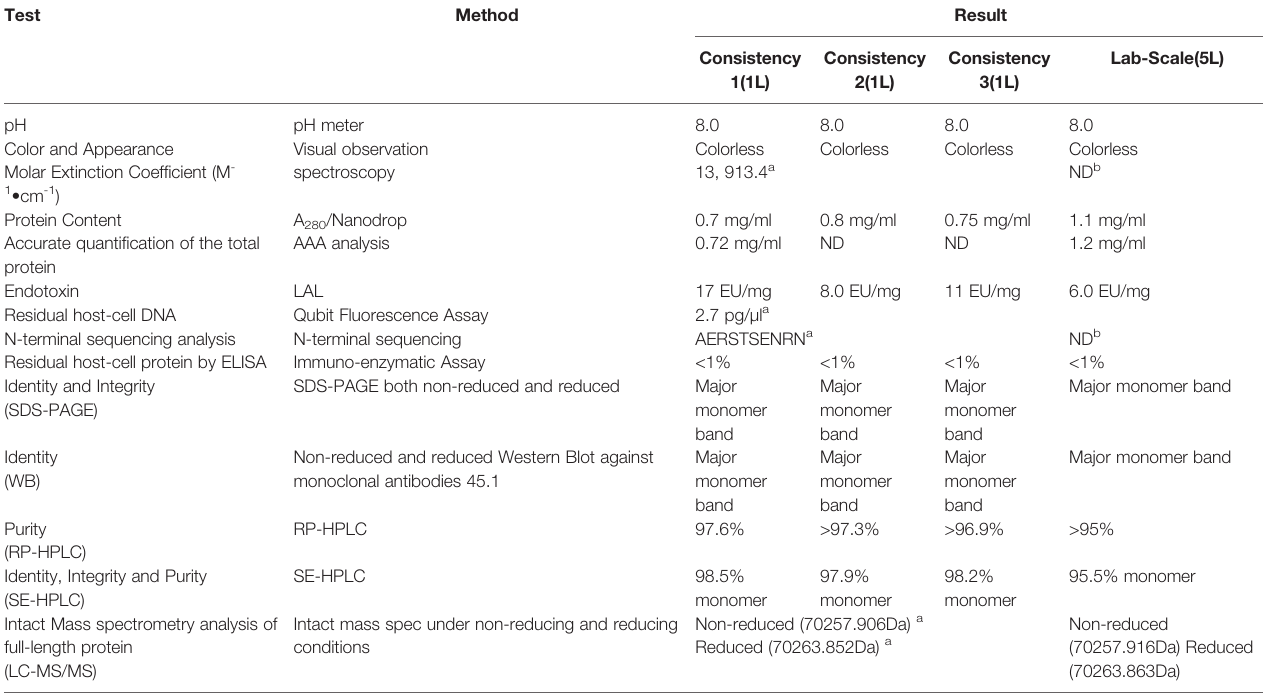
TABLE 3 | Characterization of R0.6C.